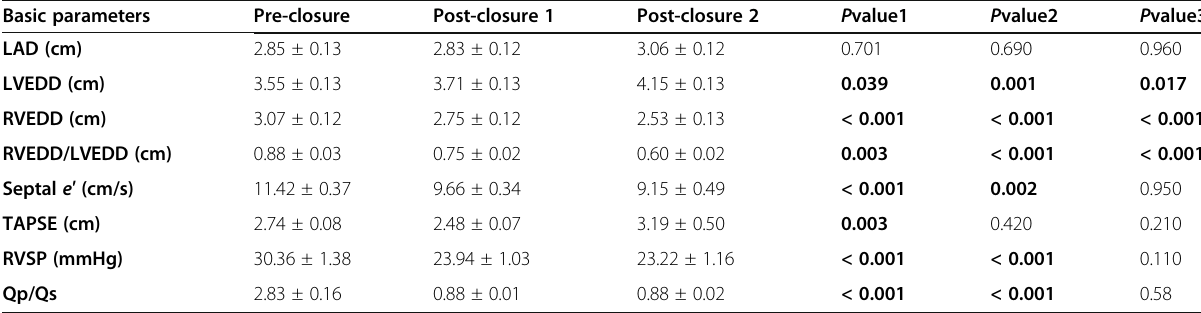
Table 3 Standard transthoracic echocardiographic measurements at baseline, 24 h and 1 month post-ASD closure Basic parameters